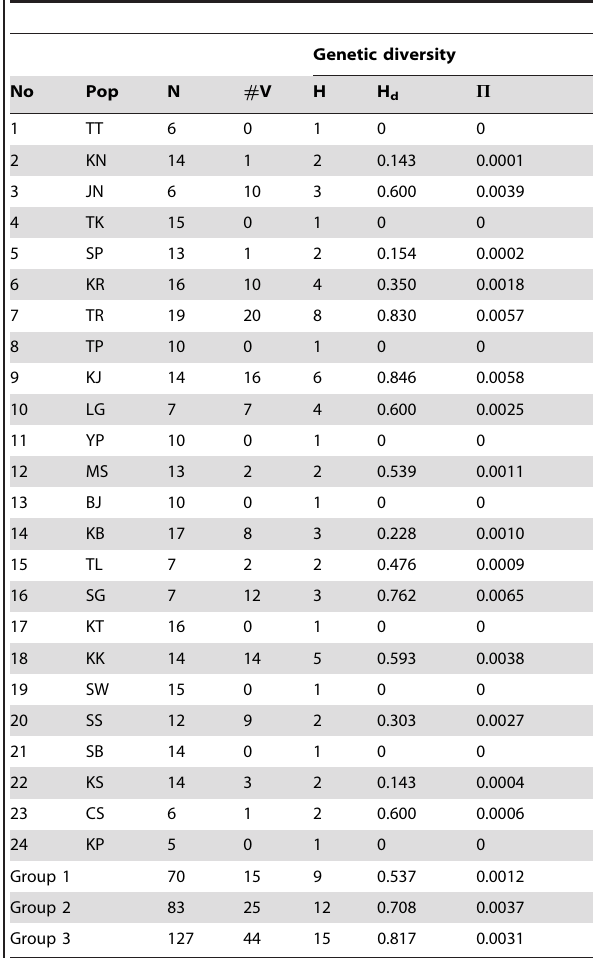
Table 2. Summary of genetic diversity of individual